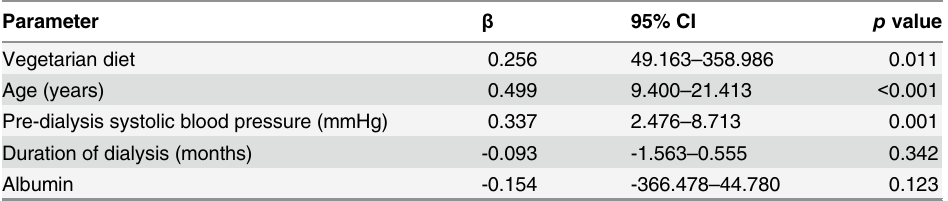
The regressions coef fi cients and 95% coef fi cient interval value are indicated. All models are after adjustment for all above covariates including diet, age, and pre-dialysis systolic blood pressure, duration of dialysis and serum